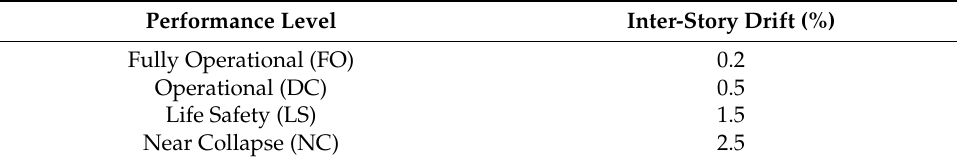
Table 2. Performance level definition as a function of inter-story drift